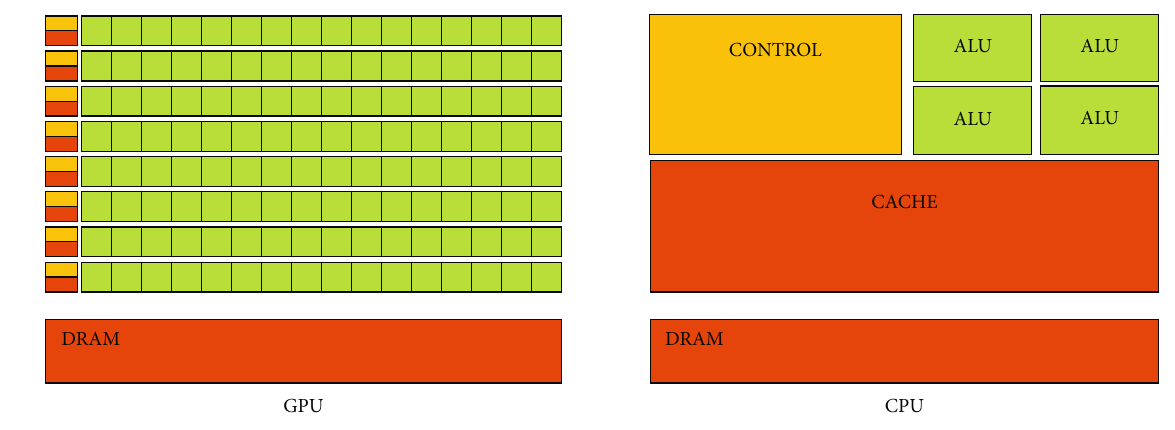
Figure 2: Schematic of GPU and CPU hardware architecture. Table 1: Comparison of computing time of di ff erent computing schemes.